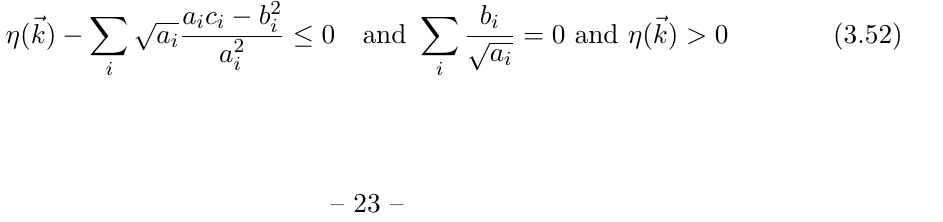
Figure 6. On the top left, an E-surface with its own normal (cid:12)eld in ( ~k one in the interior of the E-surface (purple), one on the E-surface surface (blue) and one on the exterior of the E-surface (orange) are highlighted. In the other three pictures, one can (cid:12)nd, for each of the highlighted points, the ( ~(cid:20) x ;~(cid:20) y ) space showing the forbidden line stemming from eq. (3.52) as well as the region allowed by the scaling of eq. (3.56) which guarantees that the deformation does not cross complex